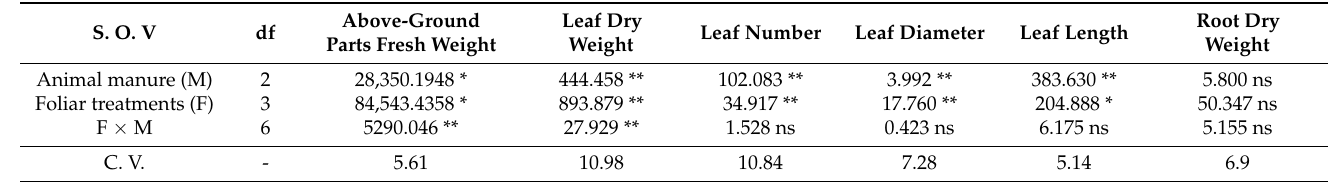
Table 2. ANOVA for the effect of animal manure (0%, 10%, and 20% v / v ) and foliar applications (sali- cylic acid, CeO 2 -nanoparticles, and CeO 2 : SA-nanoparticles) on Aloe vera L. growth characteristics.